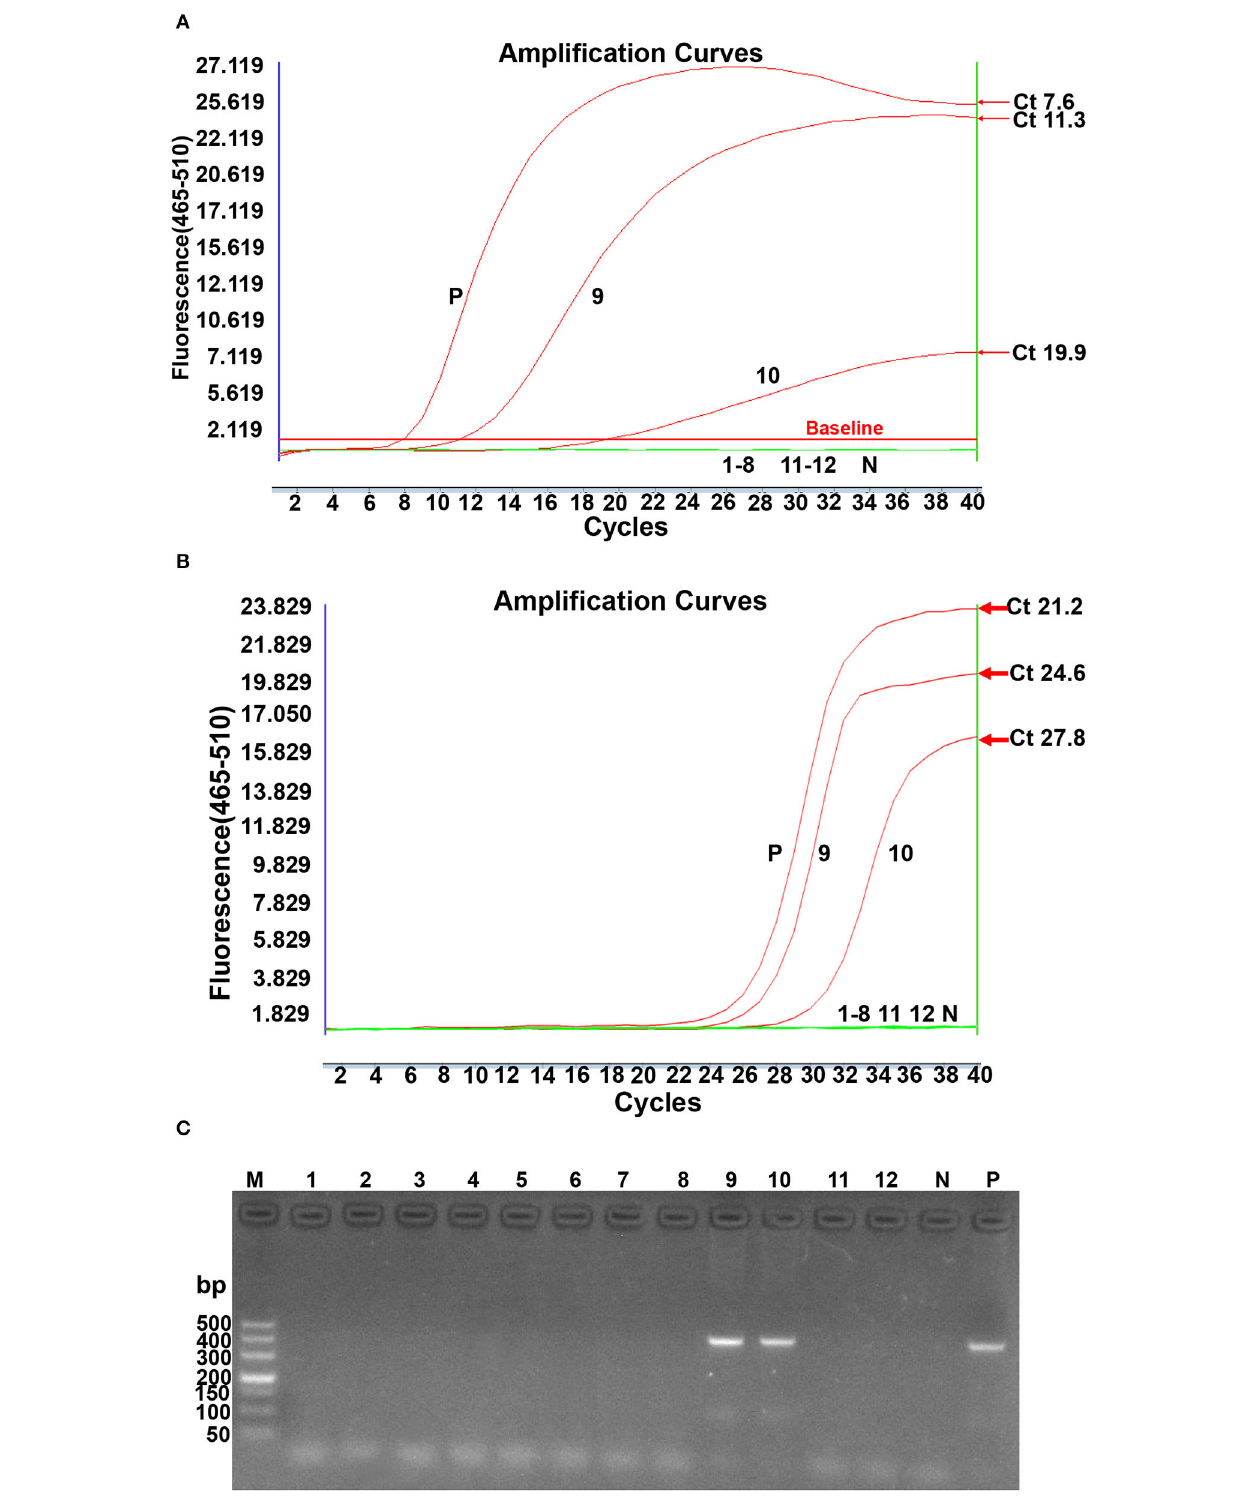
FIGURE 5 | ALV subgroup J contamination of lyophilized vaccines detected by real-time RPA, real-time PCR, and conventional PCR simultaneously. (A) . Real-time RPA detection. N: Negative; P: Positive; 1–8 lanes: Newcastle disease bivalent vaccines (Batch No. 007, 142, 152, and 063), Newcastle disease live vaccines